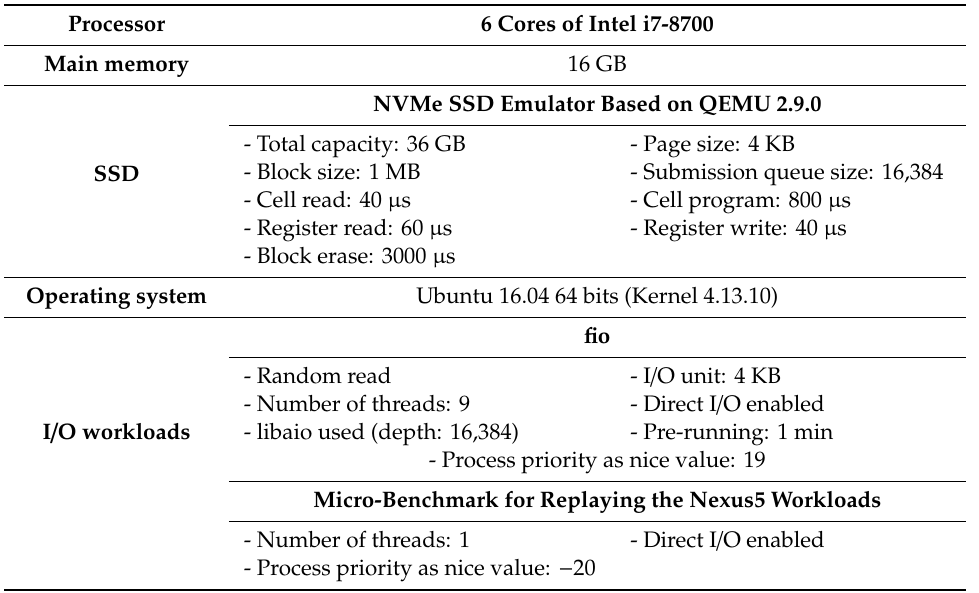
Table 4. Experimental environments.